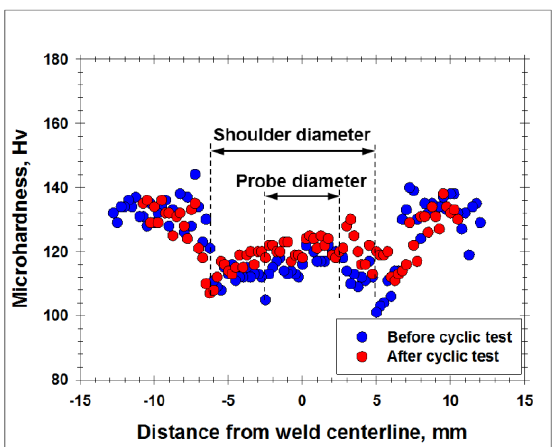
Figure 8. Effect of the fatigue tests at high cyclic stress on microhardness profile measured across the welded joint of 6061 alloy. See Section 4.3 for details. Note: The data were taken from the specimen fatigued at the maximal stress of 240